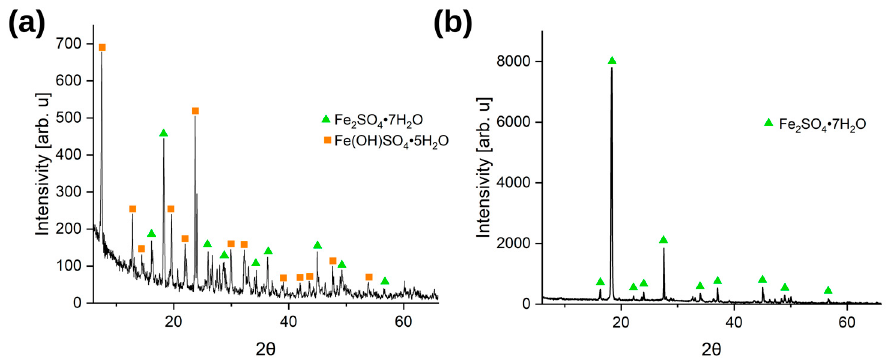
Figure 2. XRPD pattern of ( a ) waste FeSO 4 , ( b ) purified FeSO 4 .